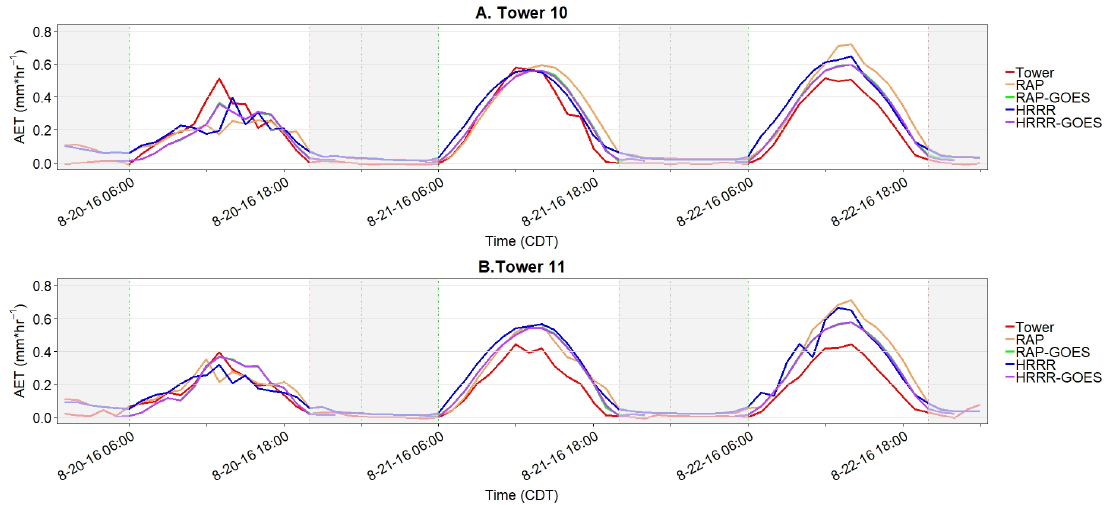
Figure 6. Time series of hourly AET estimates from four models on three randomly selected days against AET from two towers in late August 2016. The hours are in Central Daylight Time (CDT).